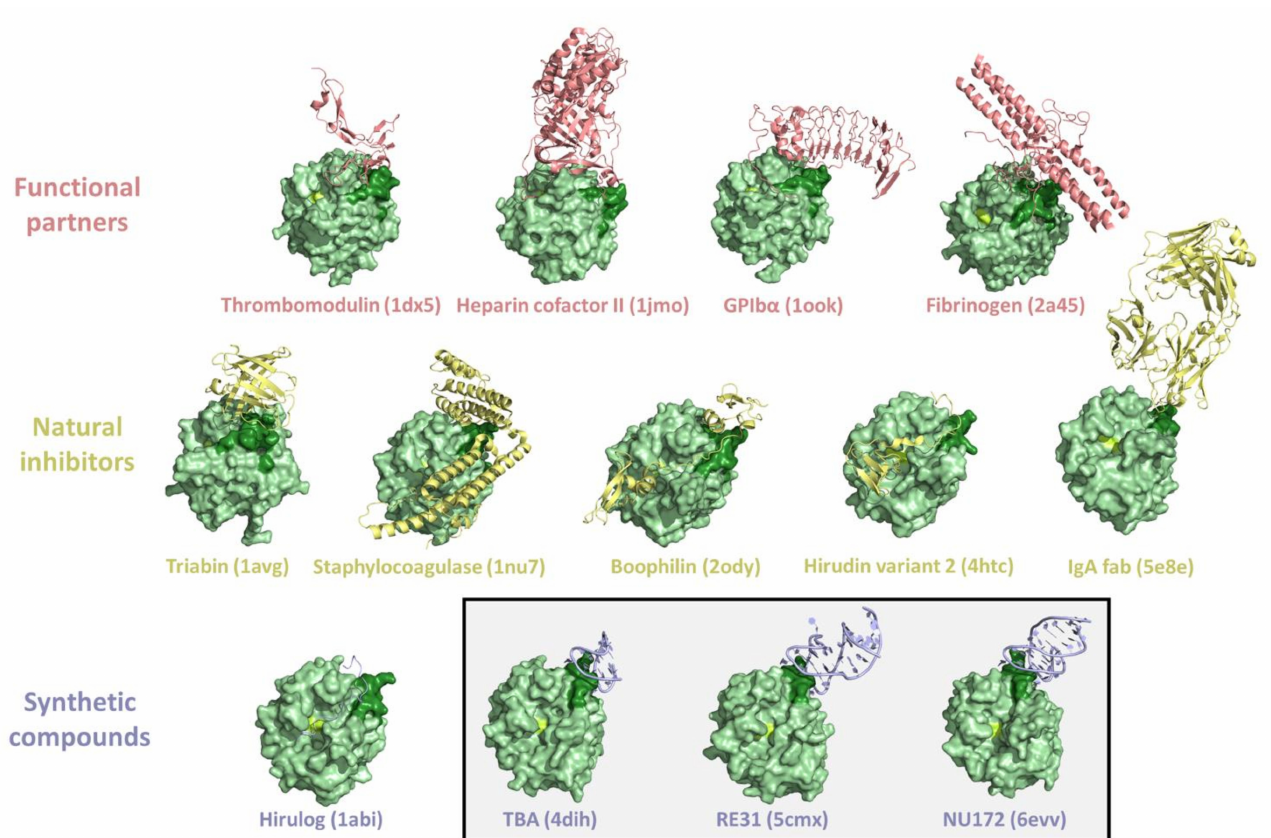
Figure 5. Representative examples of crystallographic structures of thrombin complexes with exosite I interactors (PDB entries are within brackets). The exosite I and the active triad of thrombin are in dark green and lemon, respectively. A box identifies the thrombin-aptamer